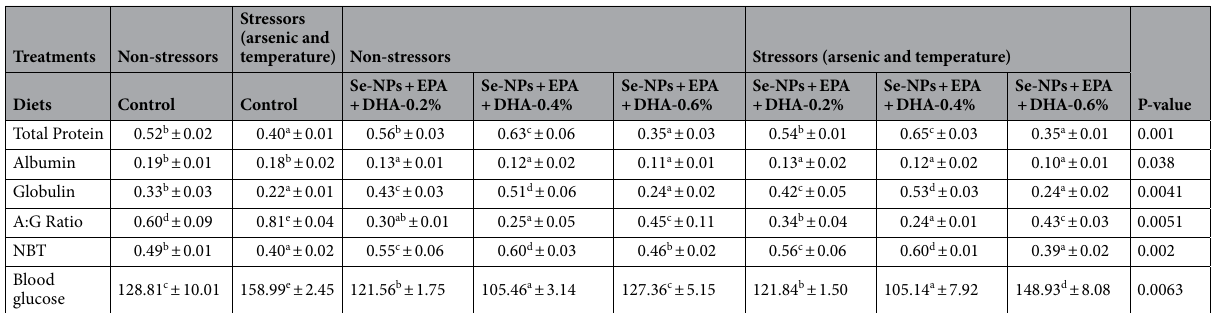
Table 5. Mitigation of secondary stress response (total protein, albumin, globulin, A:G ratio and blood glucose) through dietary supplementation of selenium nanoparticles, eicosapentanoic acid and dicosahexanoic acid fed to P. hypophthalmus reared in control or under arsenic and high temperature for 105 days. Values in the same row with different superscript (a, b, c, d, e) differ significantly. Total protein, albumin, globulin: g dL −1 Blood glucose: mgdL −1 ; Data expressed as Mean ± SE (n =